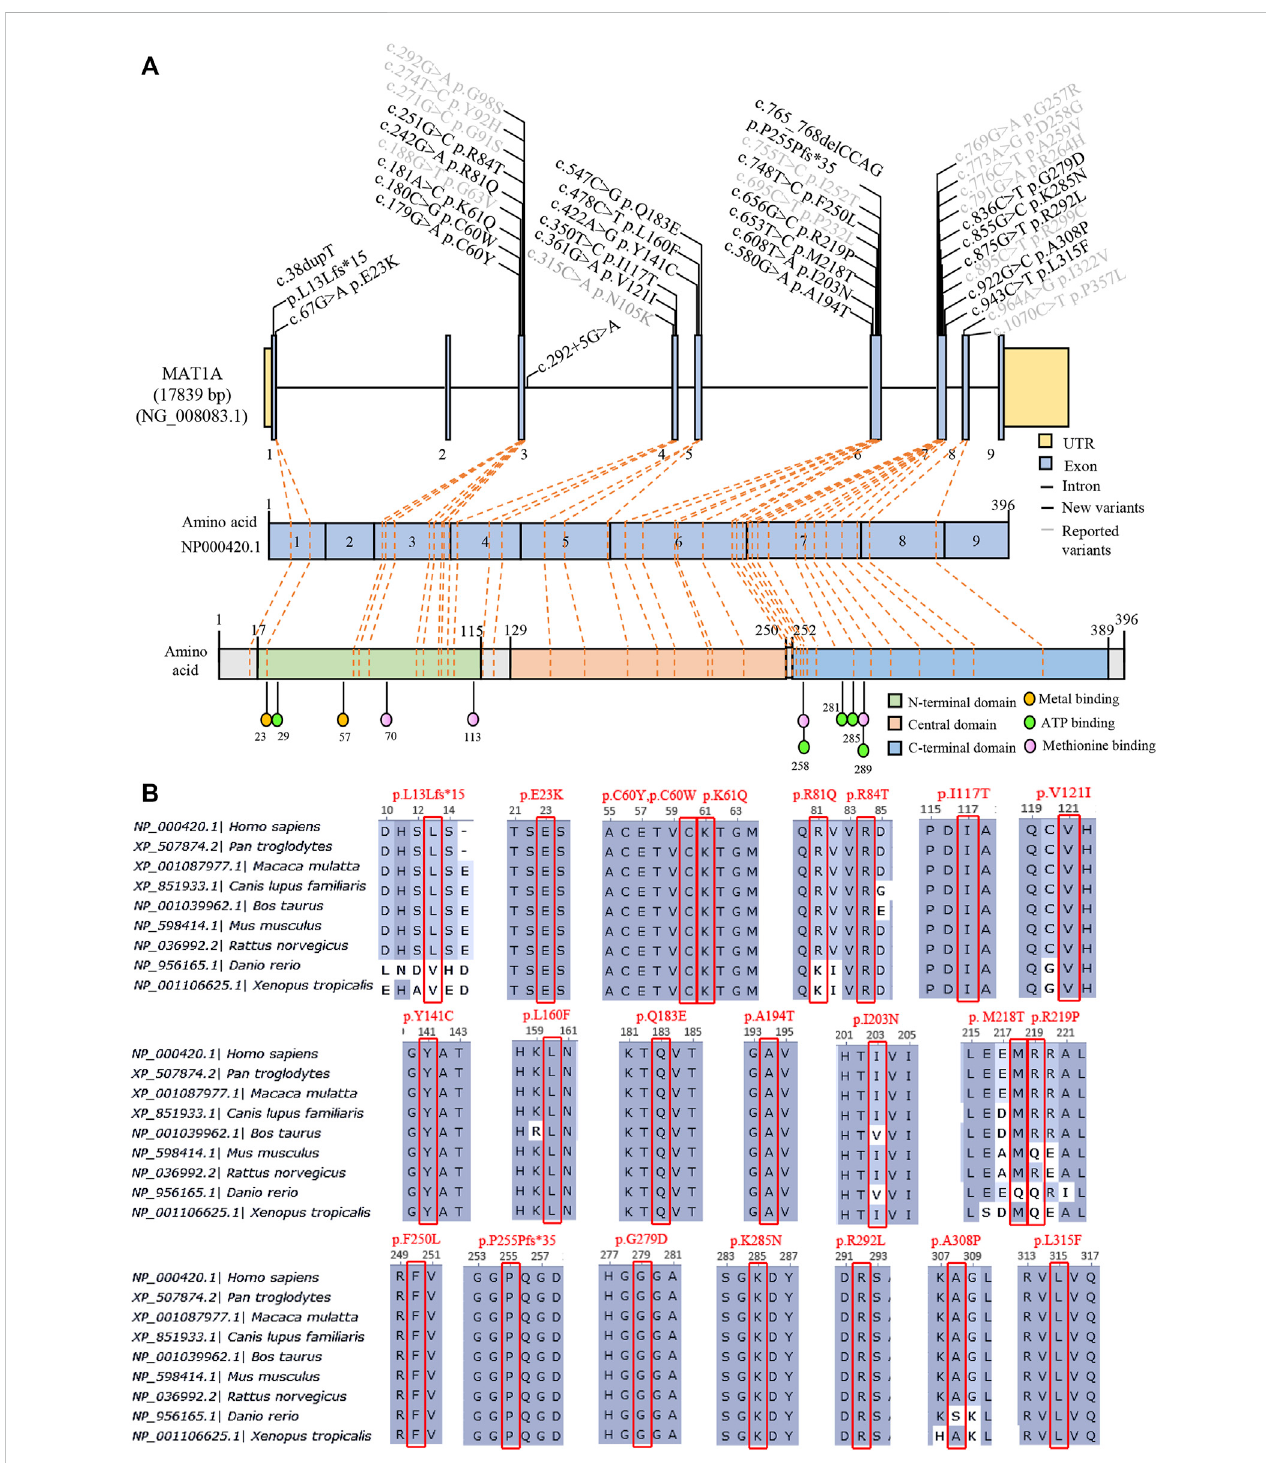
FIGURE 3 Summary of 38 variants of MAT1A identi fi ed in MATD patients and carriers. (A) Distribution of 38 variants in the MAT1A gene and protein among MATD patients and carriers. Black, 24 novel variants found in this study; grey, reported variants in MATD elsewhere. (B) Conservation analysis of 24 novel variants in different species, excluding the splicing c.292 + 5G >